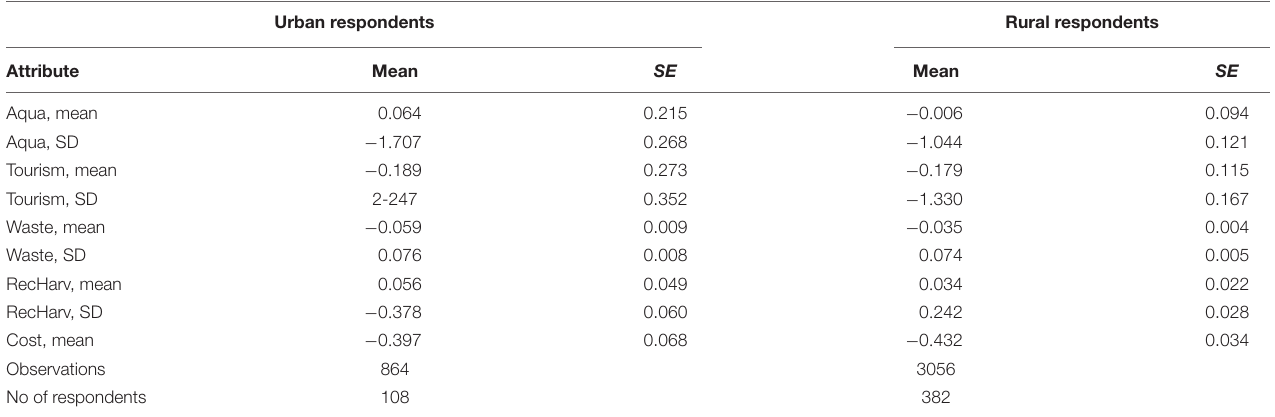
TABLE A2 | Preference estimates for urban and rural respondents for the recreation dataset.